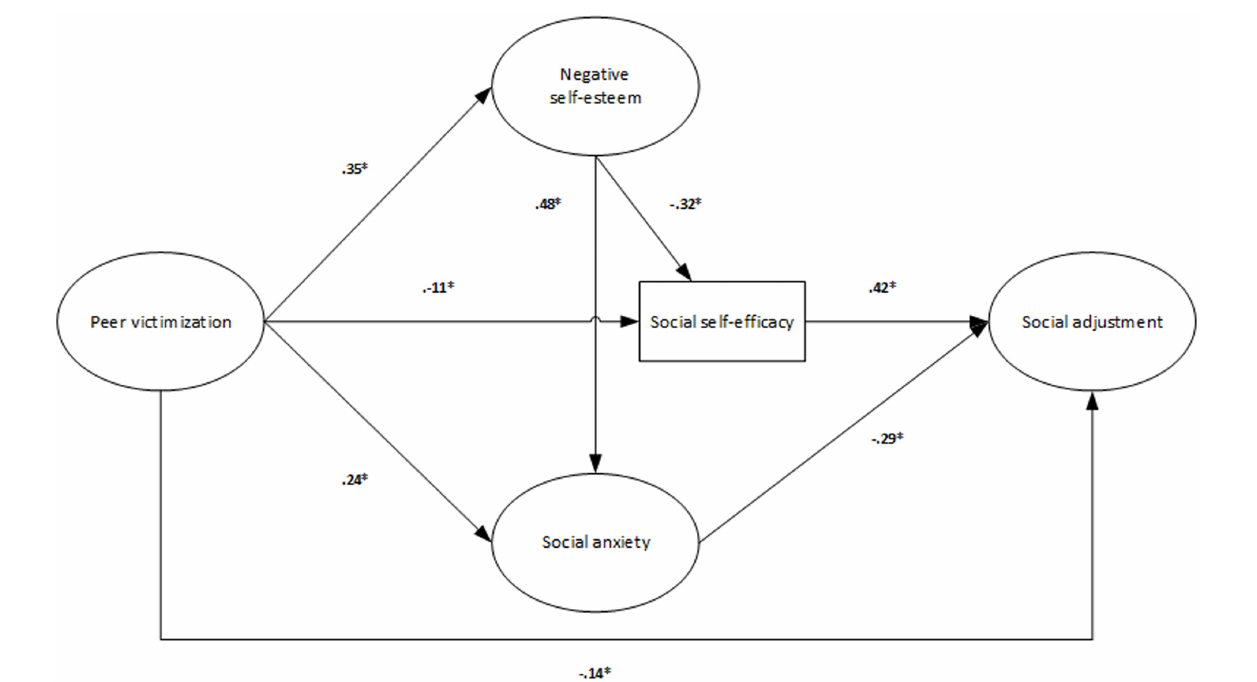
FIGURE 2 | Fifth model: direct and indirect relationships between victimization, psychological and social adjustment which place psychological adjustment as a mediator between victimization and social